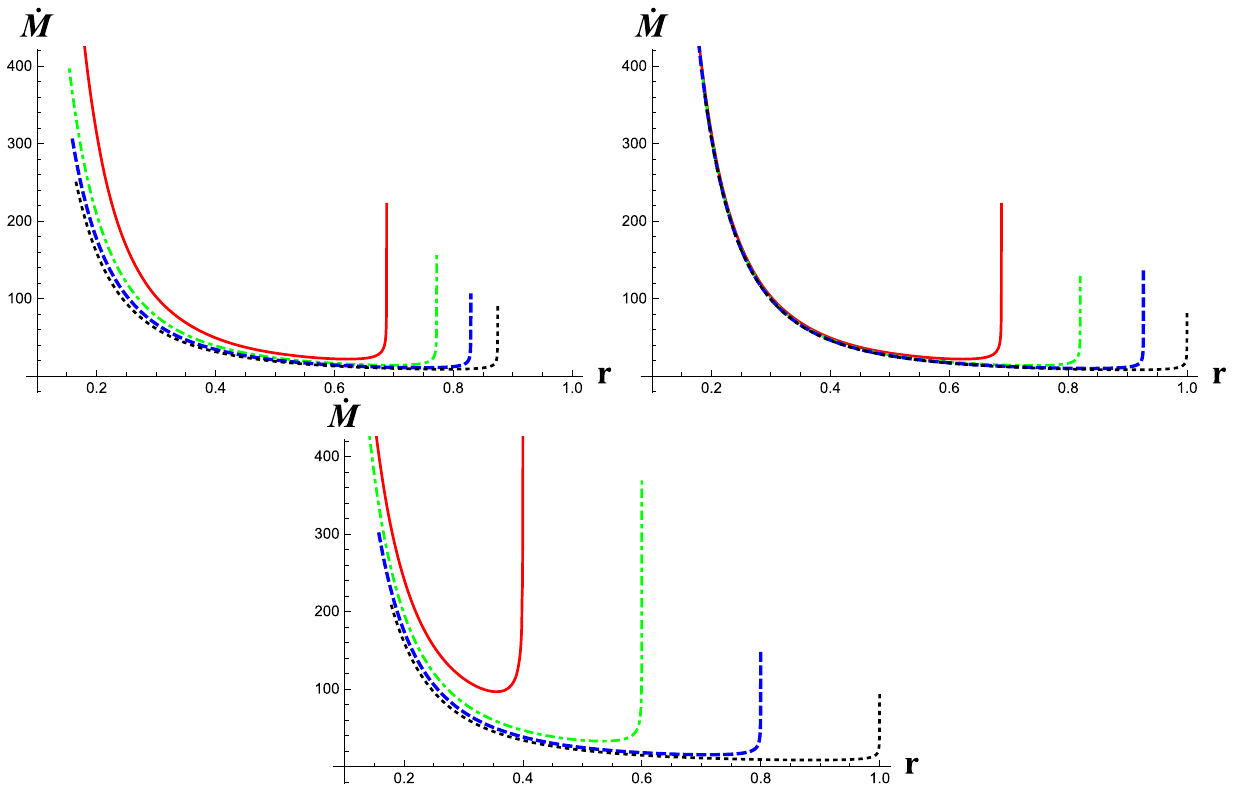
Fig. 11 For the mass accretion rate, left panel displays the behavior of conformal gravity BH with conformal parameters γ = 0 . 1, k = − 1, β = 1. Right panel displays the behavior of Schwarzschild–de Sitter